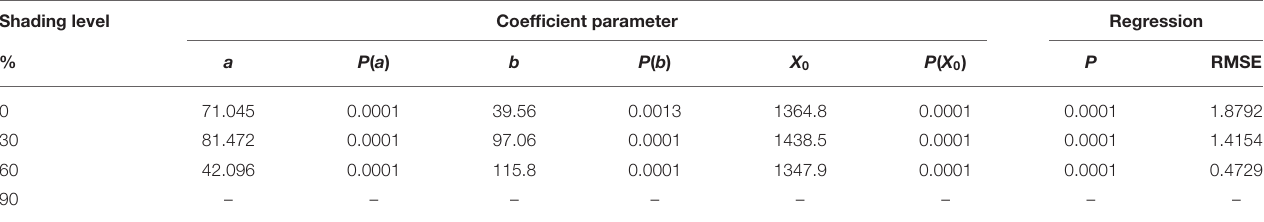
TABLE 5 | The coefficient of three parameters log-logistic equation fitted to describe the effect of shade levels on Parthenium hysterophorus final number of flowers per plant. Shading level Coefficient parameter